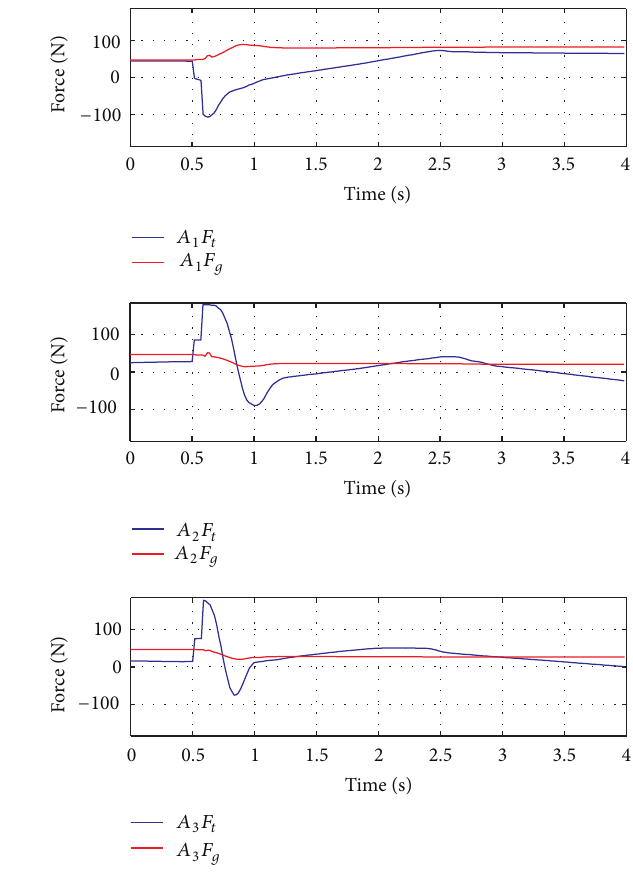
Figure 13: Joint-space PID with gravity compensation: 𝐹 𝑡 total force provided by the motors, 𝐹 𝑔 gravity component.